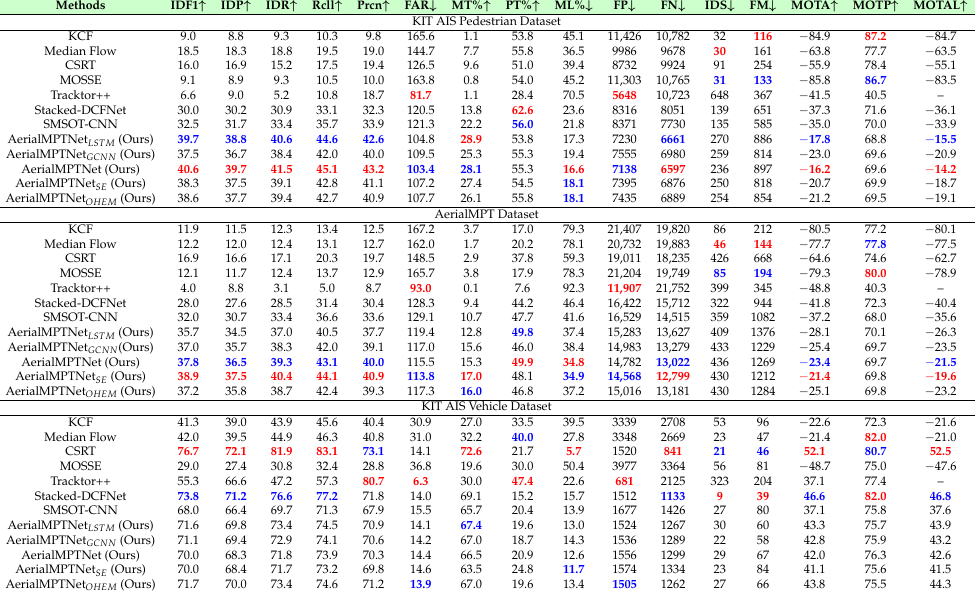
Table 12. Overall Performances of Different Tracking Methods on the KIT AIS and AerialMPT Datasets. The first and second best values on each dataset are highlighted.